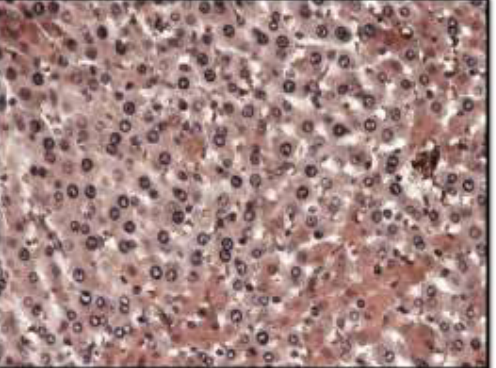
Figure 7a: Photomicrograph of H&E stained 4 µm thick liver section showing congestion but no Fat droplets (vacuoles) in rat hepatocytes on high-fat diet + Ginseng 400mg/kg (group 5) at ×400.